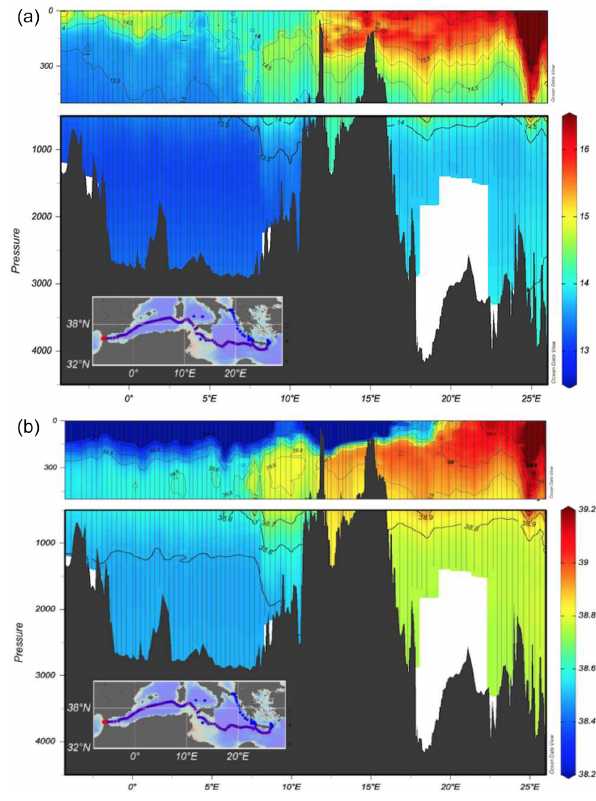
Figure 2. West–east temperature (a) and salinity (b) sections through the Mediterranean